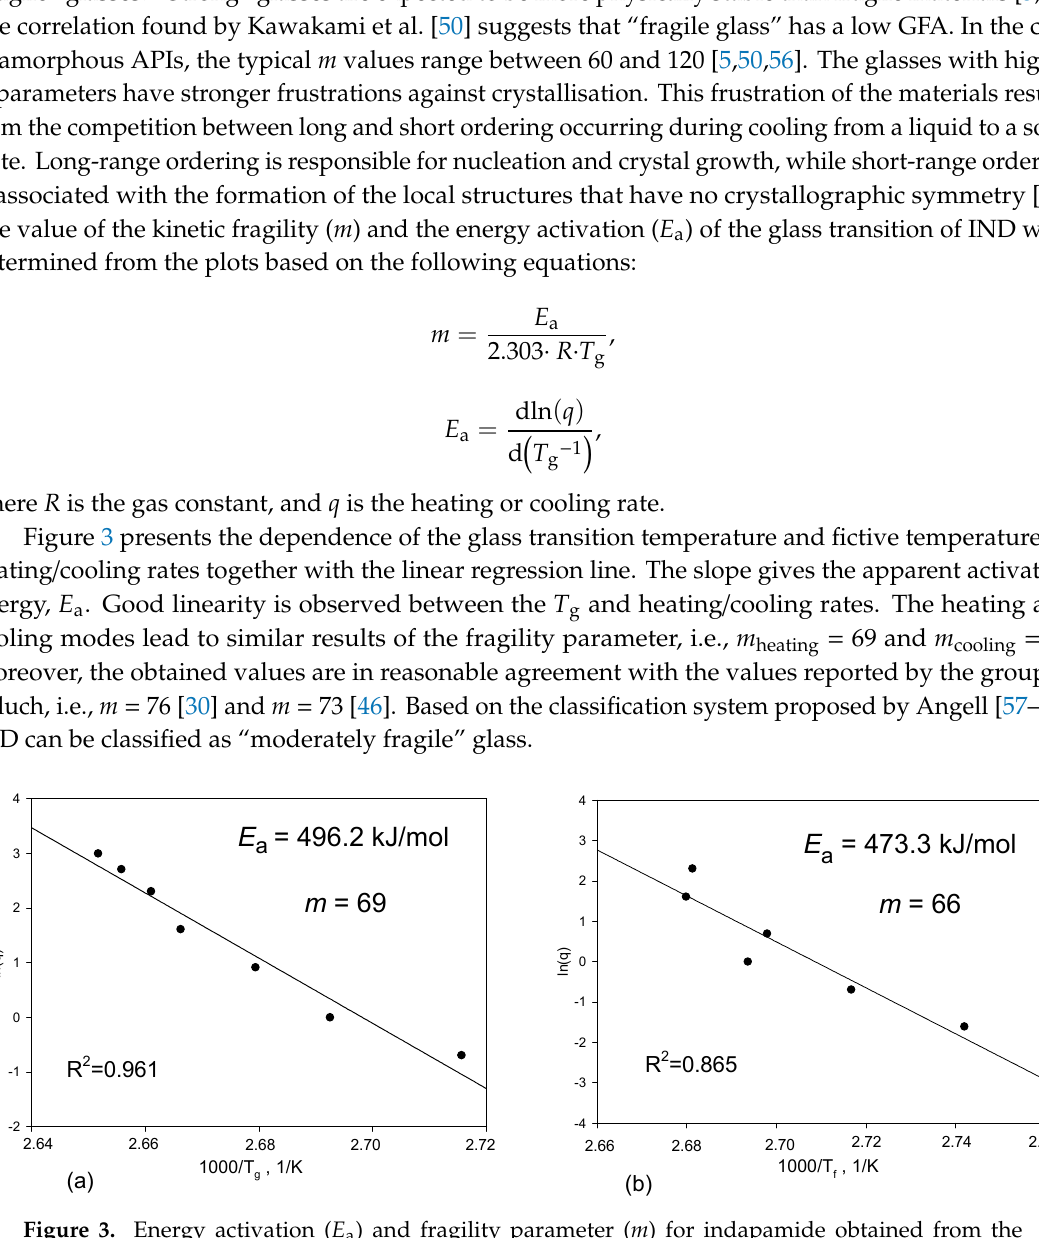
Figure 3. Energy activation ( E a ) and fragility parameter ( m ) for indapamide obtained from the dependence of the glass transition temperature ( T g ) and fictive temperature ( T f ) on ( a ) the heating and ( b ) cooling rates.